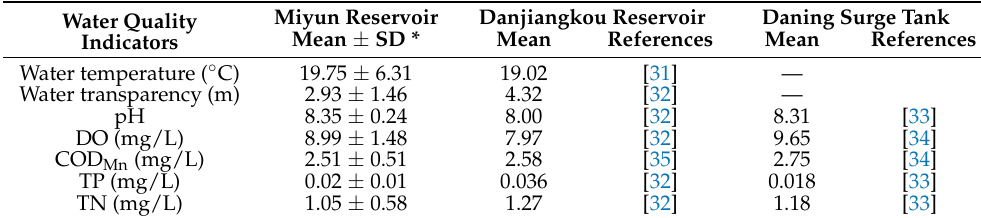
Table 1. Water environmental indicators in three